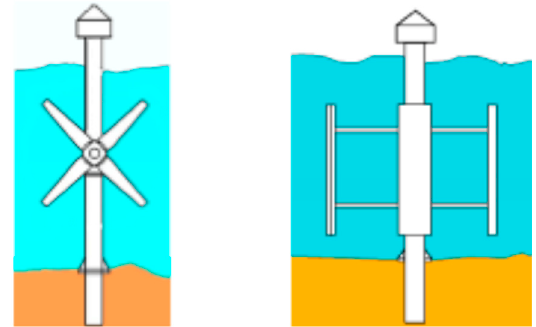
Figure 8. Marine current devices, axial rotor and cross flow.